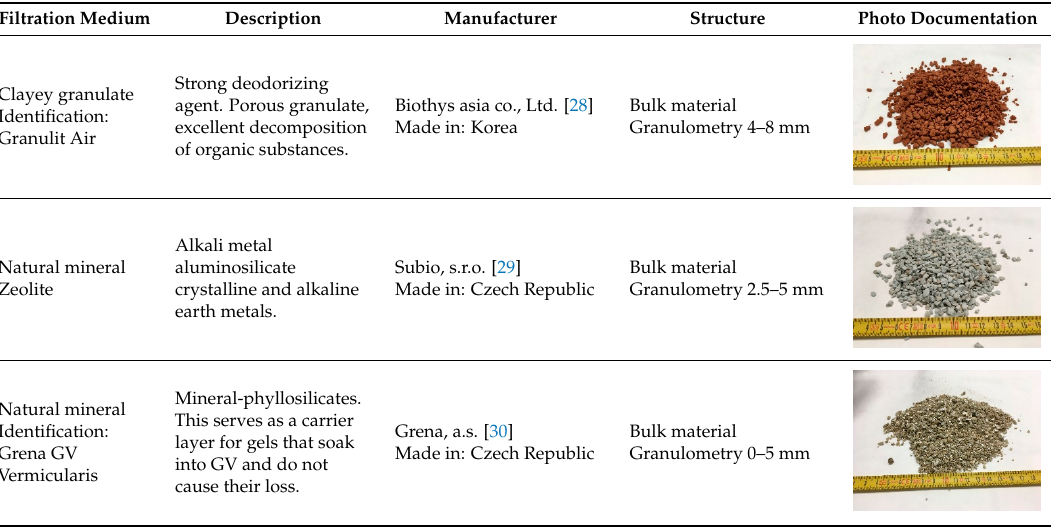
Table 4. Selected filter medium granulates.